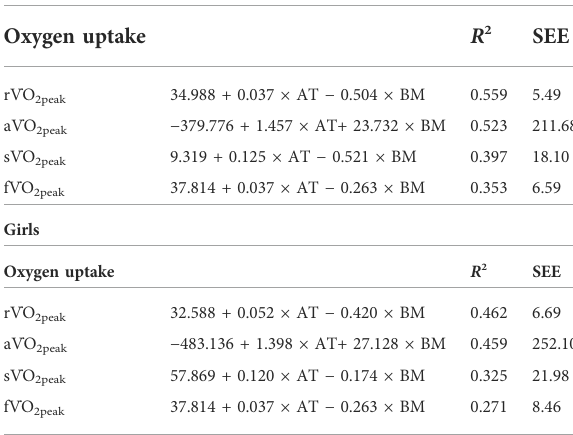
(boys: 148 m and girls 133 m) (Figure 2). A comparison of the results for each year (cross-sectional) with the longitudinal results revealed only minor, non-signi fi cant differences in oxygen uptake and running performance. Cohen ’ s d effect